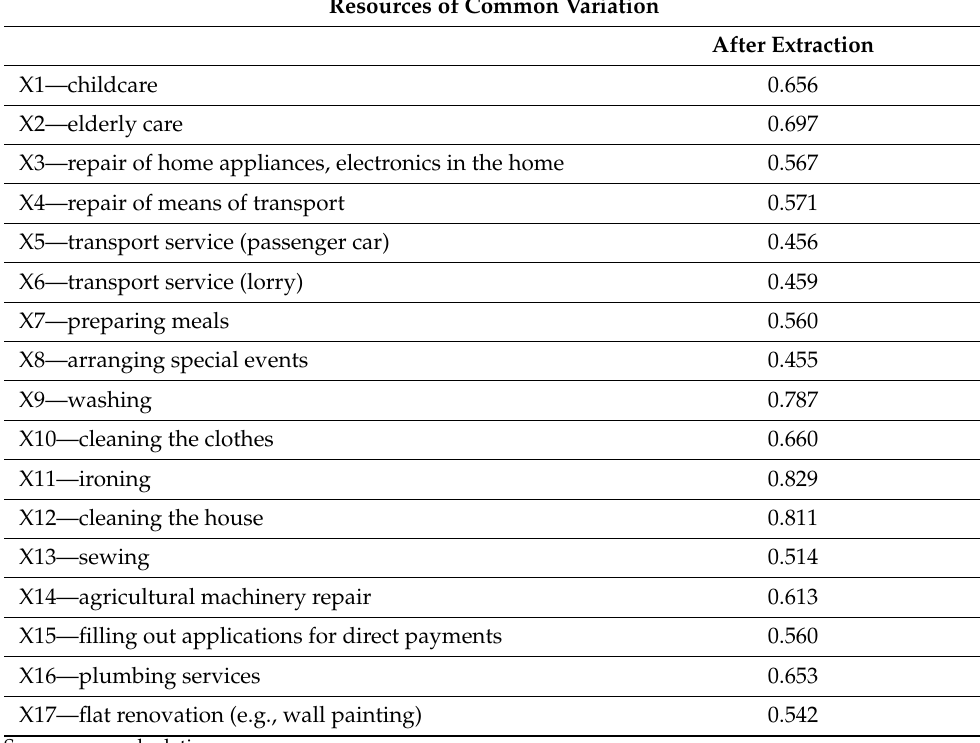
Table 5. Statistics for common variation